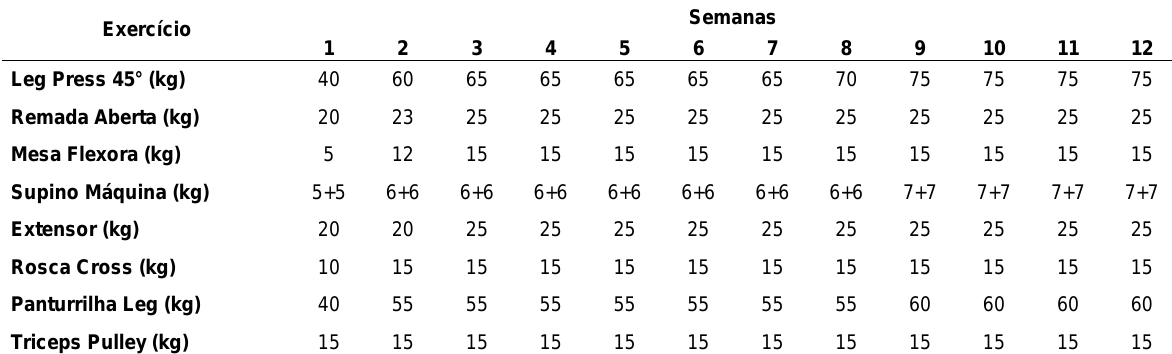
Tabela 1. Programa de treinamento resistido com descritivo da